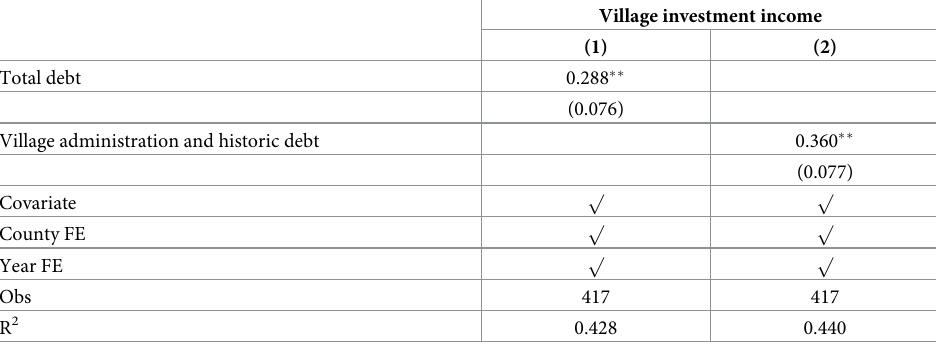
Table 6. The estimation results of the relationship between village-level debt and investment